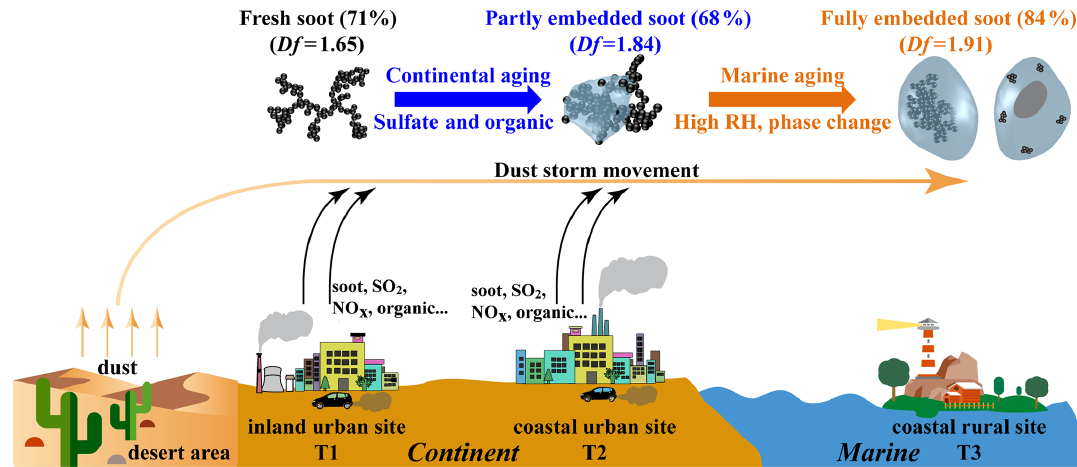
Figure 8. Schematic diagram showing the evolution of morphology and mixing state of soot particles along with the movement of an Asian dust